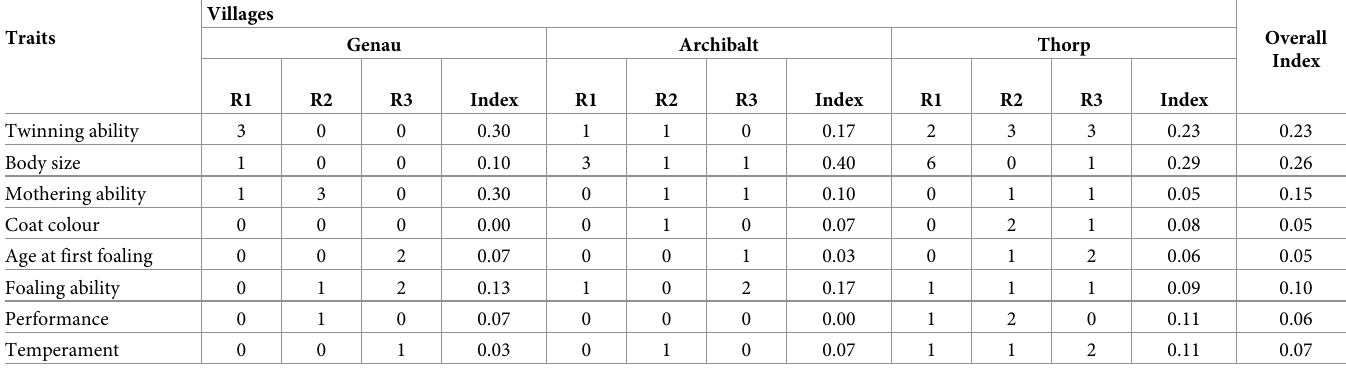
Table 5. Ranks and indices for trait preference in female donkeys.